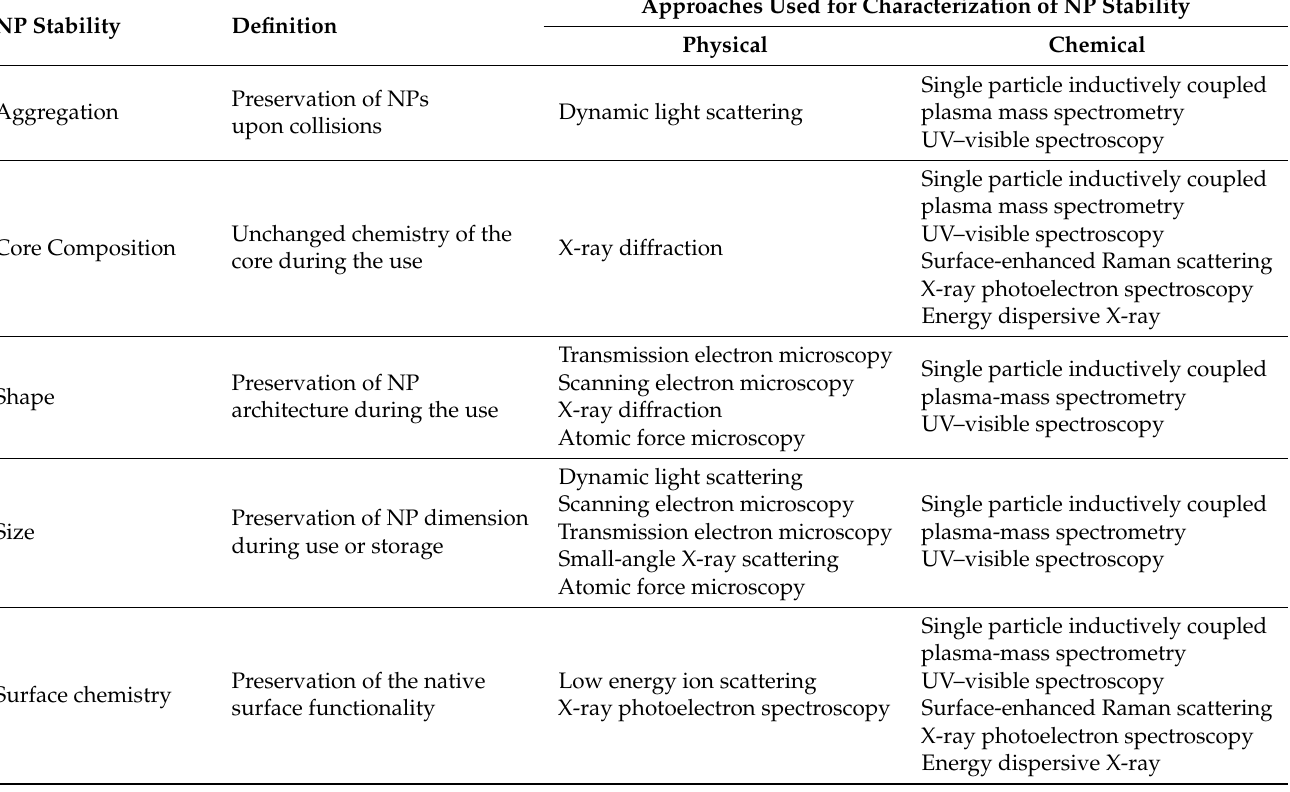
Table 5. Key parameters defining NP stability and strategies to determine stability